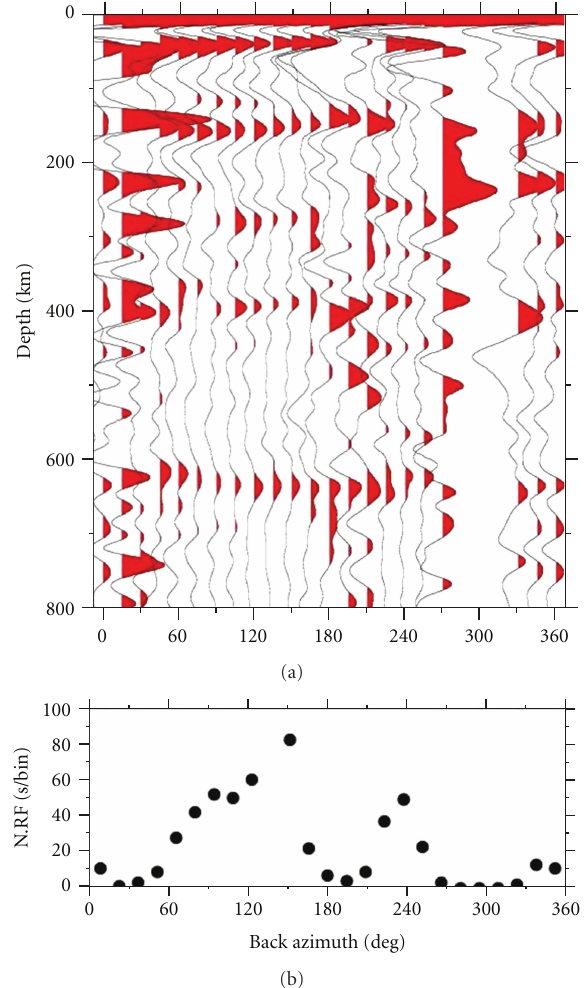
Figure 6: (a) Back azimuth distribution for the depth converted receiver functions in the upper mantle compiled for all the GARNET stations. The number of receiver functions for each 15 azimuth range is shown in (b). The back azimuths are represented from Syowa Station (SYO) against the depth conversion points calculated for all the hypocenter-station